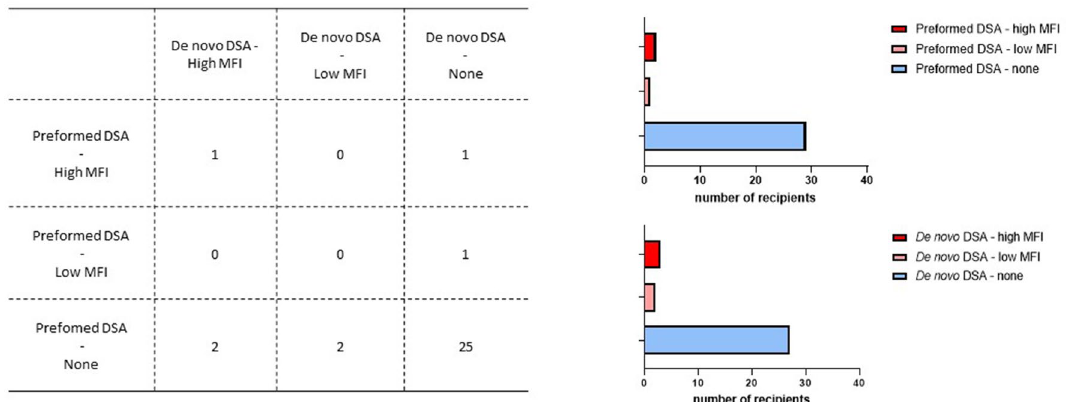
Figure 2. Distribution of donor specific antibodies in a cohort of type 1 diabetic pancreatic islets recipients. There are nine possible combinations considering the presence or not of preformed or de novo DSA and the level of MFI (left Table). High MFI was considered with a cut-off of 3000. A majority of recipients does not present with either preformed or de novo DSA (preformed DSA: top right graph; de novo DSA below: right graph). DSA: Donor Specific Antibodies. MFI Mean Fluorescence